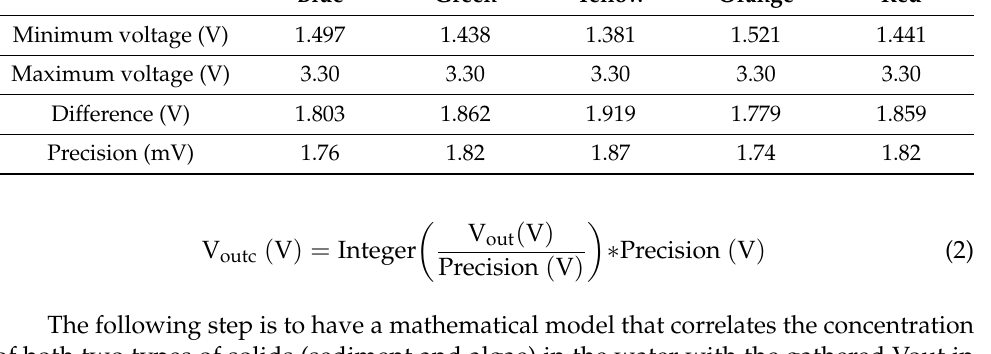
Table 5. The precision of the analogy entry. Blue Green Yellow Orange